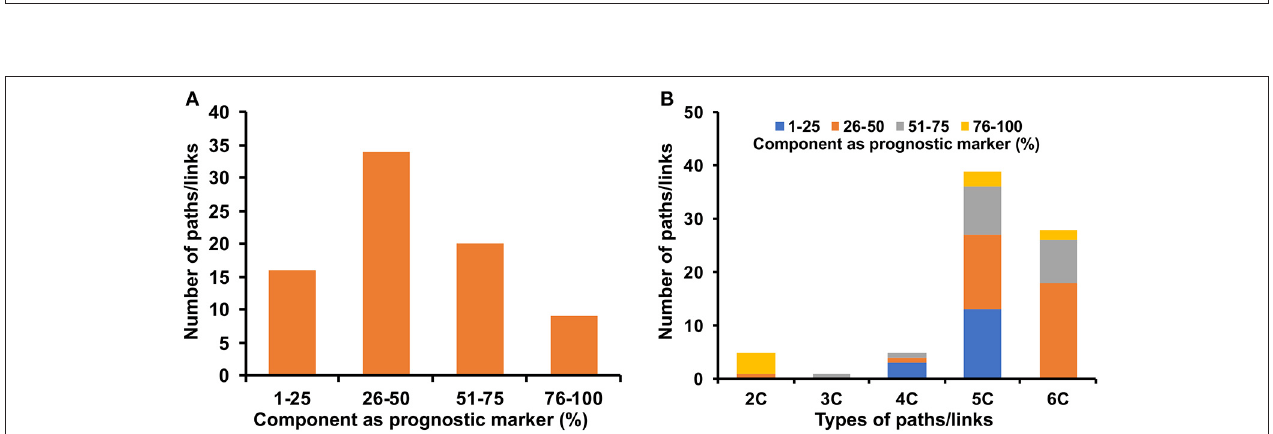
FIGURE 7 | Prognostic markers in identified cross-connecting paths. (A) shows the fraction of components as a prognostic marker of cervical cancer in the identified paths/links. (B) shows the fraction of components as a prognostic marker in different types (2, 3, 4, 5, and 6C) of identified cross-connecting paths/links.